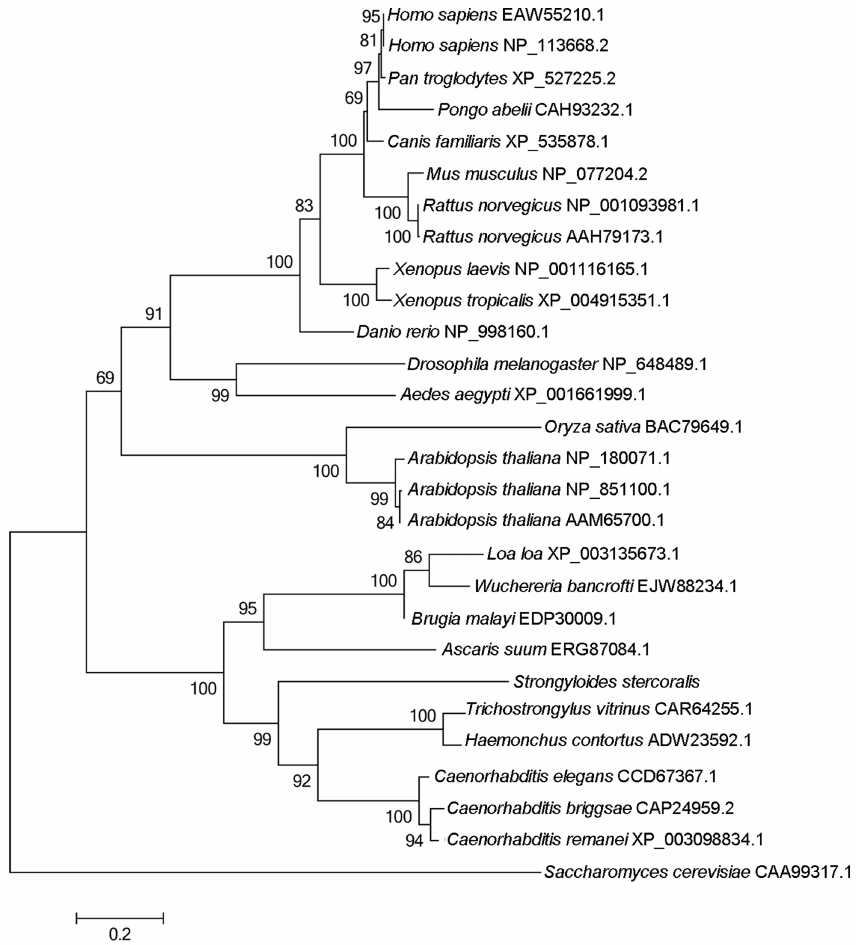
Figure 2. The Neighbor-joining tree of StrongyloidesstercoralisSs -RIOK-1 with 27 homologues from 23 selected species. These species contain nine nematode species, two plant species, two insects, three fish and amphibian species and six mammalian species. The RIOK-1 from Saccharomyces cerevisiae (CAA99317.1) is used as the outgroup. GenBank accession numbers of the homologous sequences are listed beside the species name. Bootstrap values are displayed above or below the branches.